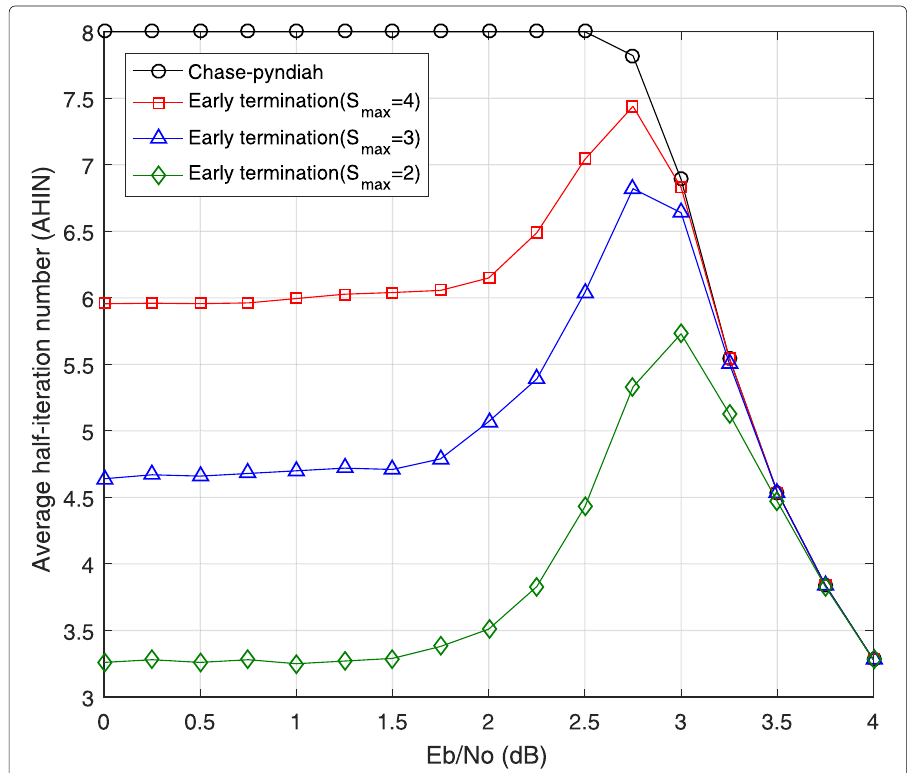
Fig. 6 Average half-iteration number before and after application of the proposed early termination algorithm for the ( 64,57,4 ) 2 TPC. I max ,8 (i.e., the number of maximum full-iterations, 4), LRB number, 4